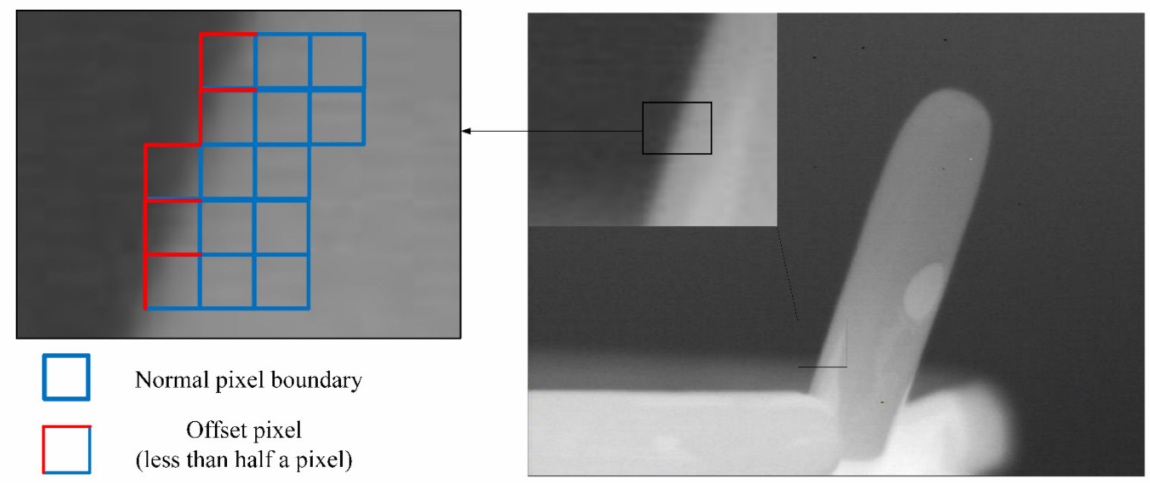
Figure 25. The infrared image after image